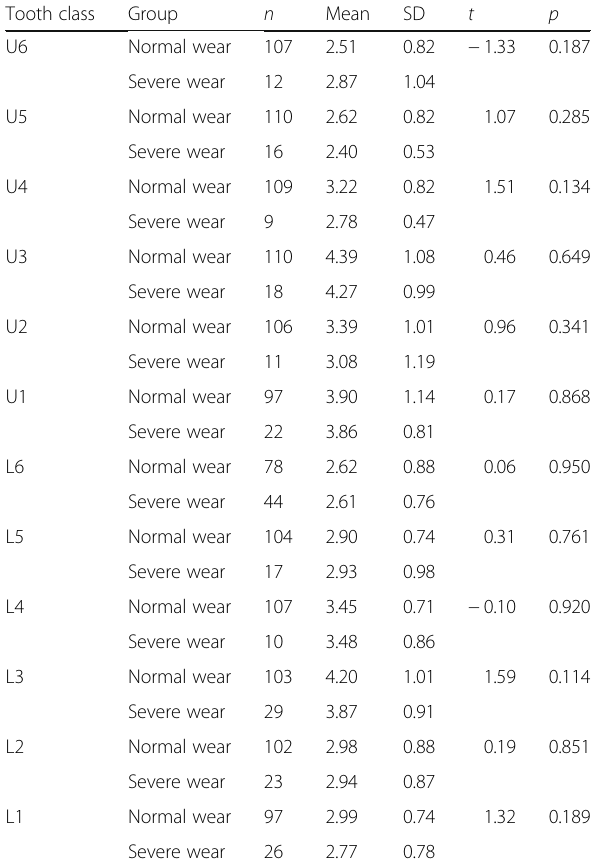
Table 7 Independent t -tests comparing the gingival margin- papillae measurements for the normal wear and severe wear subsets for the combined four groups